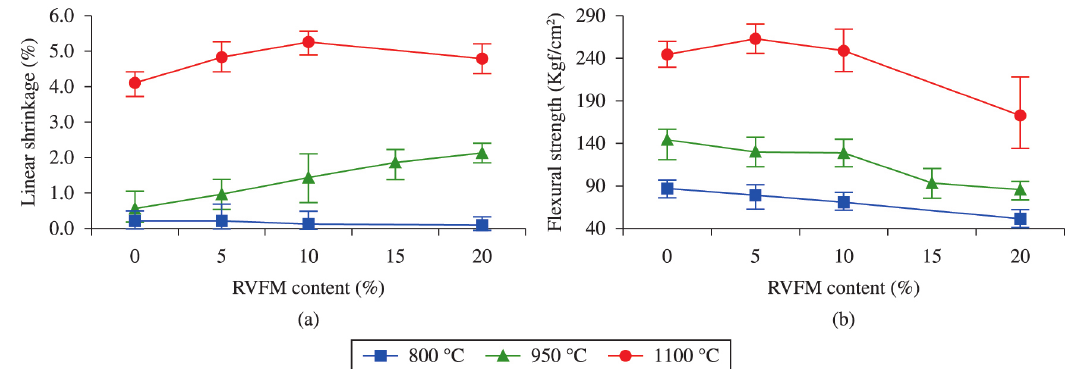
Figure 5. Effect of RVFM addition on linear shrinkage (a) and flexural strength (b) of ceramic bricks fired at varying